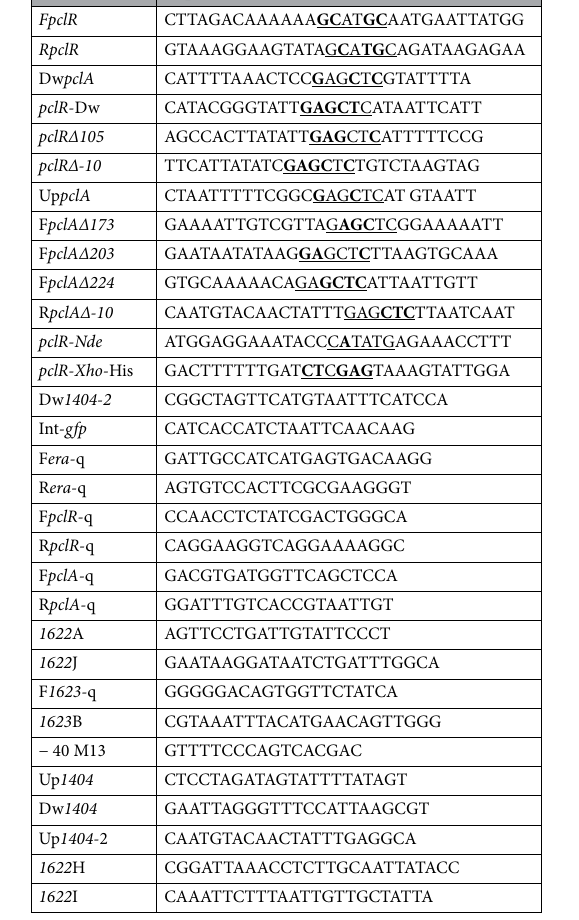
Table 1. Oligonucleotides used in this work. a Restriction sites are underlined, and the base changes that generate restriction sites are in